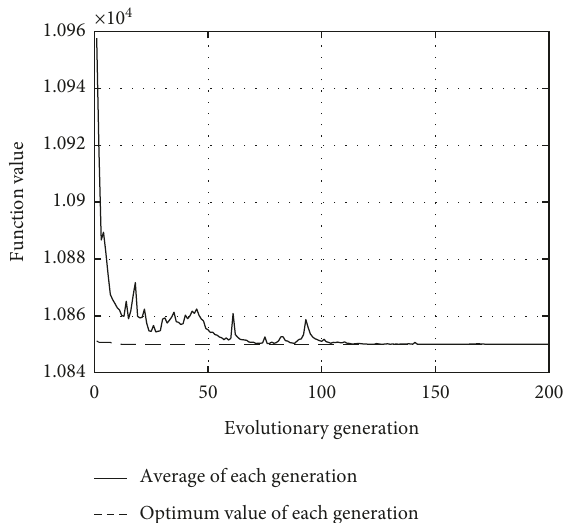
Figure 5: Variation of the fitness function with the